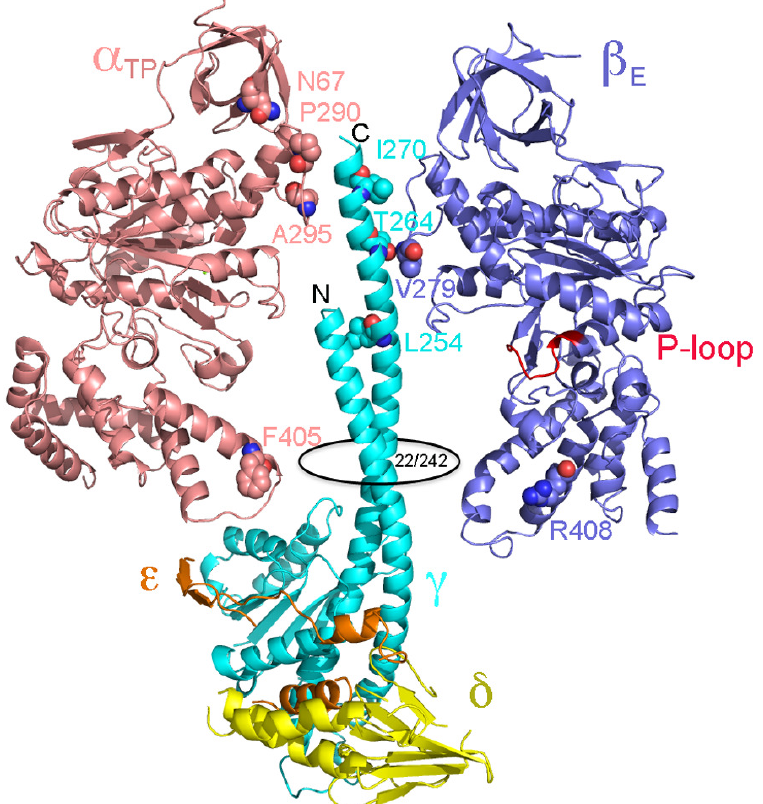
FIGURE 3: Location of residues in the yeast ATP synthase classified as mgi . The structural repre- sentation is derived from the x-ray structure of the yeast F 1 ATPase (2HDL). Shown are the αβγδε subunits, as indicated. The α 3 β 3 core has been stripped down to a single α and β subunit to sim- plify the view. The mgi residues are as labeled. The N- and C- terminal ends of the γ-subunit are indicated as is the region of the orifice of the α 3 β 3 assembly, which is located at residues 22 and 242 of the yeast γ-subunit. The nucleotide binding P- loop domain is colored red and